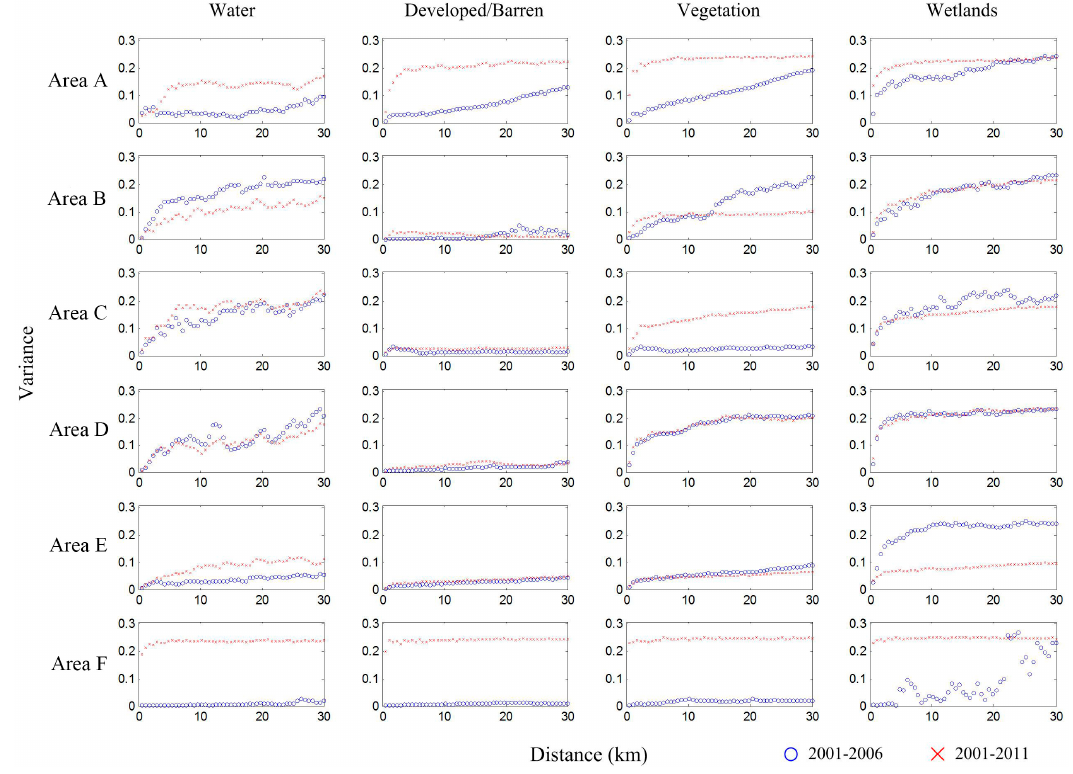
Figure 8. The variance values for the six study areas during 2001–2006 and 2001–2011 with different land cover classes in the four-class scheme.